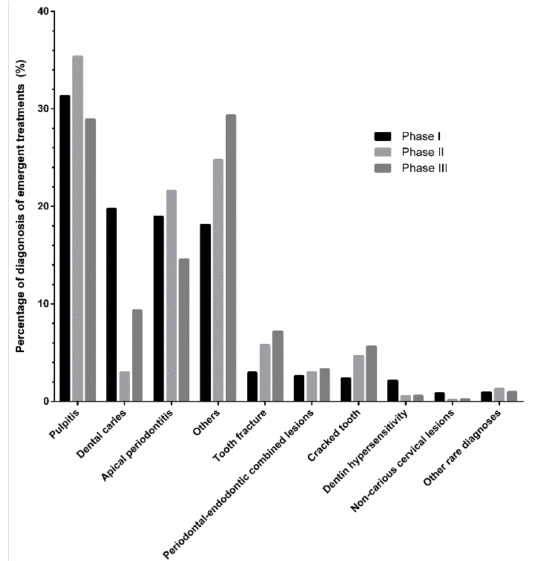
Figure 3. Percentages of ODE-related diagnoses during three periods (rare ODE-related diagnoses included external root resorption, pulp calcification, and other rare diagnoses). Phase I: 9 January to 22 January 2020; Phase II: 23 January to 7 April 2020; Phase III: 8 April to 21 April 2020. ODE: operative dentistry and endodontics.